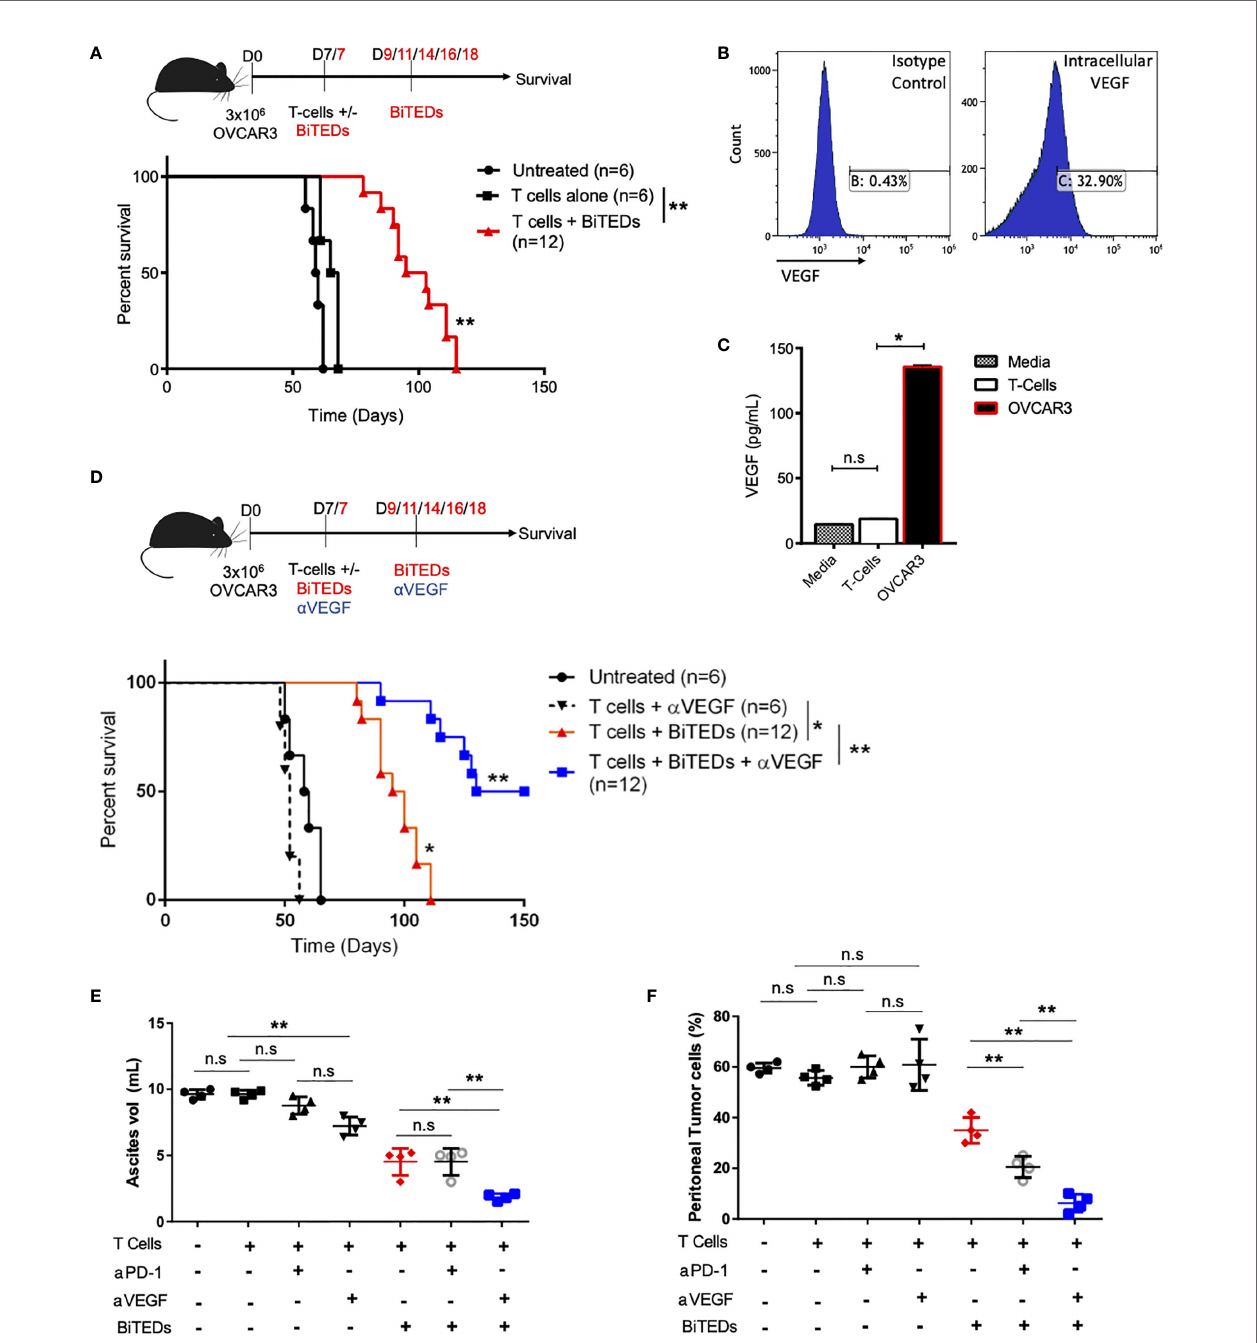
FIGURE 6 | MUC16 ecto -BiTEDs in combination with VEGF inhibition signi fi cantly improves ascites, peritoneal tumor burden, and overall survival. (A) Female NSG mice were inoculated i.p with OVCAR3 tumor cells and treated with T-cells alone or T-cells and MUC16 ecto - BiTEDs. Data shown are pooled results from 2 independent experiments with at least 4 independent Leukopak donors. Data are plotted as mean ± SEM. **p < 0.05. Tumor was injected on D0 i.p. T-cells were injected on D7 i.v in all animals. Animals that received BiTEDs treated were dosed i.p on D7, D9, D11, D14, D16 and D18. (B) Expression level of VEGF in OVCAR3 cells by fl ow cytometry. (C) Evaluation of VEGF in supernatant collected from T-cells and OVCAR3. T-cells vs OVCAR3 (*p < 0.05). (D) OVCAR3 tumor-bearing mice treated with T-cells + a VEGF, T-cells + BiTEDs, or T-cells + BiTEDs + a VEGF. Data are plotted as mean ± SEM. T cells + a VEGF vs T cells + BiTEDs (*p < 0.005). T cells + BiTEDs vs T cells + BiTEDs + a VEGF (**p < 0.005). Statistical analysis for (a) and (d) performed using a log-rank (Mantel-Cox) test. Tumor was injected on D0 i.p. T-cells were injected on D7 i.v in all animals. Animals that received BiTEDs treated were dosed i.p on D7, D9, D11, D14, D16 and D18. Anti-VEGF (clone hvegf-mab1) was injected i.p. on D7, D11, D14, D18, and D21. (E) Volume of ascites collected from OVCAR3 tumor-bearing mice treated with T-cells alone, T-cells + a PD-1, T-cells + a VEGF, T-cells + BiTEDs, T-cells + a PD-1 + BiTEDs, or T-cells + a VEGF + BiTEDs. Data shown are pooled results from 2 independent experiments with at least 2 independent Leukopak donors. Data are plotted as mean ± SEM. **p < 0.05. (F) Percentage of MUC16 POS , CD45 - peritoneal tumor cells corresponding to the same conditions as in (E) . Data are plotted as mean ± SEM. **p < 0.05. ns, not signi fi